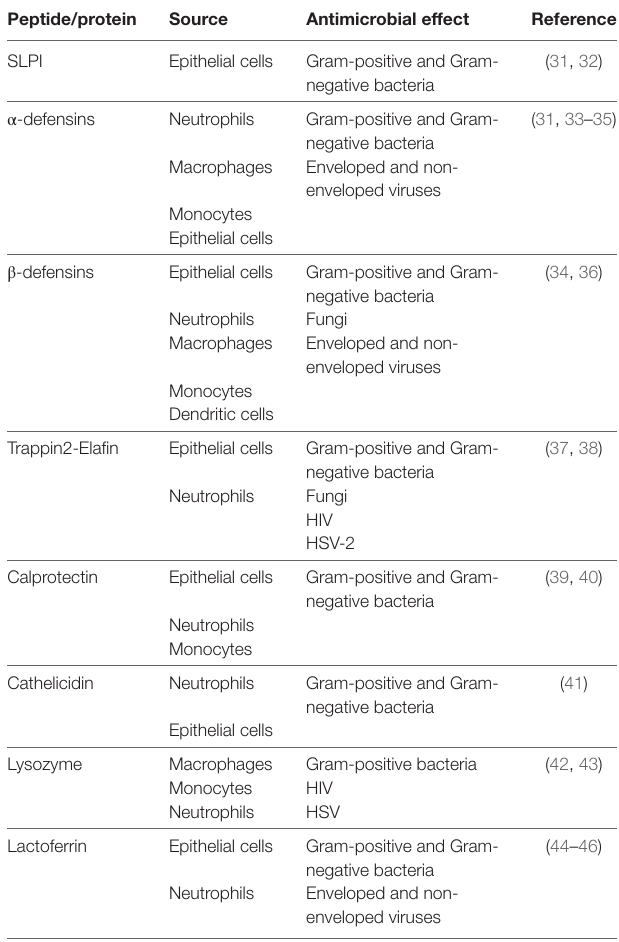
TabLe 1 | Antimicrobial peptides/proteins of the female genital tract.